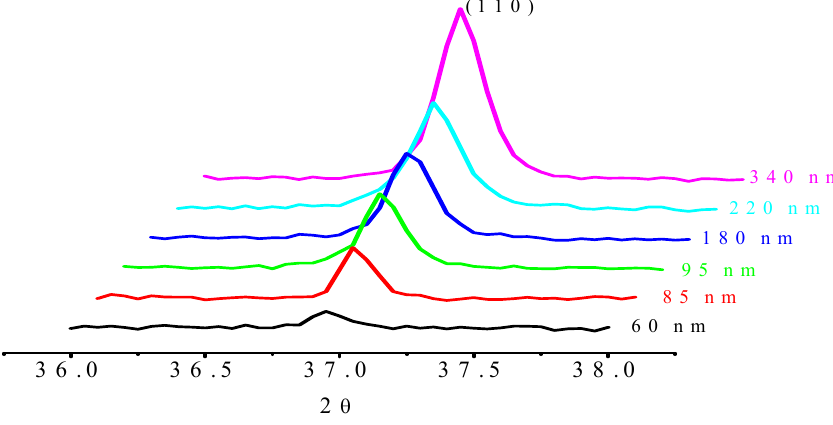
Figure 3. X-ray of IR-PLD CdS thin films with different thicknesses. X-ray line broadening of the (110) reflection of the as-deposited CdS thin films with different thicknesses is represented in Figure 3. The crystallite size and micro-strain as a function of film thickness are determined and represented in Figure 4a, b, respectively. From Figure 4a, it is observed that the average crystallite size in ‐ creases with increasing the film thickness. The observation of A. Amith [25] and J.